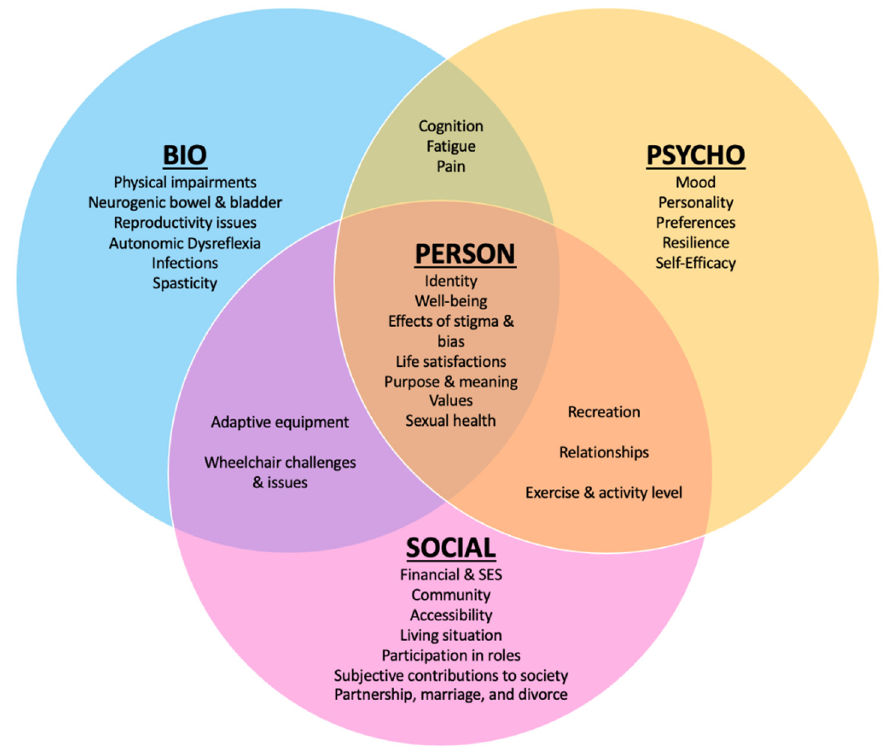
Figure 1. Biopsychosocial model of interacting factors for persons with SCI.